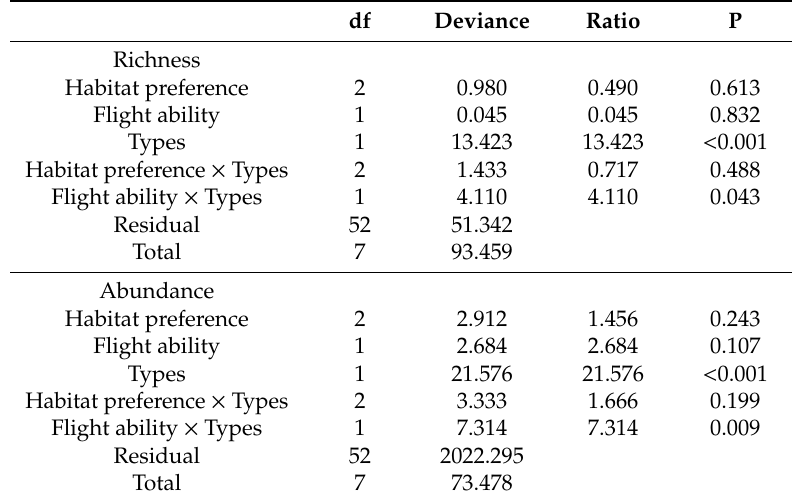
Table 3. Interaction between carabid beetles’ types (former or current habitat types) by the generalized linear model.